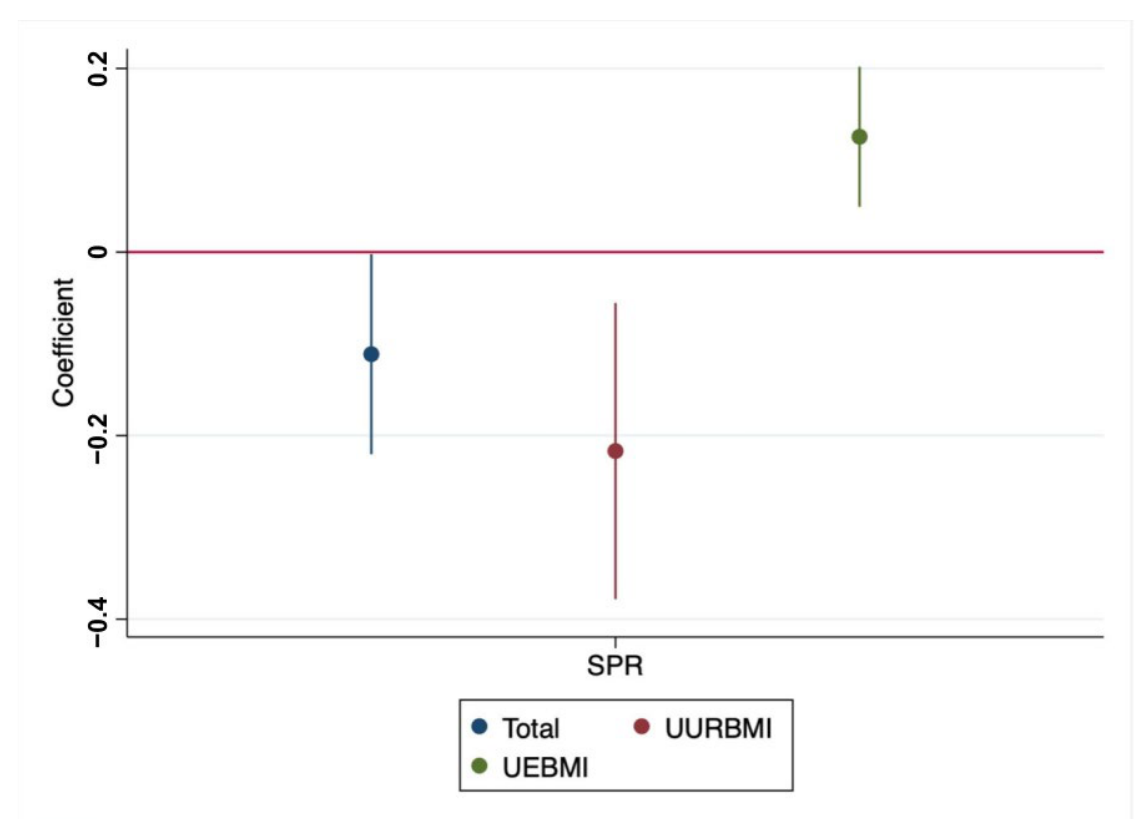
Figure 3. The effect of the SPR on medical expenses borne by the UURBMI and UEBMI. The figure plots the coefficients and their associated 95% confidence interval from Column 3 of Table 2 (marked in blue) and Columns 1 and 4 of Table 3 (marked in red and green). Vertical bands represent 95% confidence intervals, adjusted for county-level clustering.